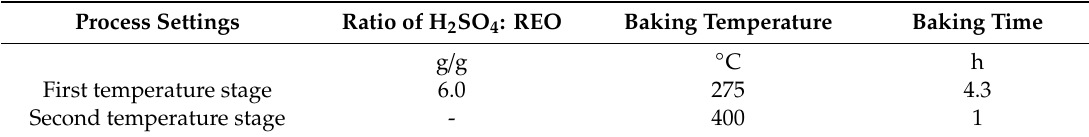
Table 5. Optimum process parameters for a selective extraction elements from the monazite concentrate based on DoE and additional experiments. Process Settings Ratio of H 2 SO 4 : REO Baking Temperature Baking